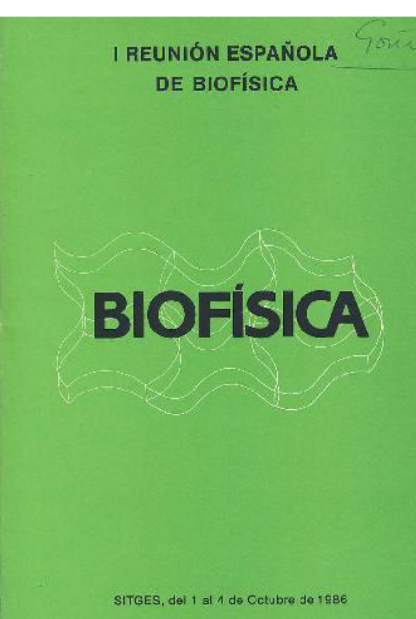
1969 Barcelona meeting.